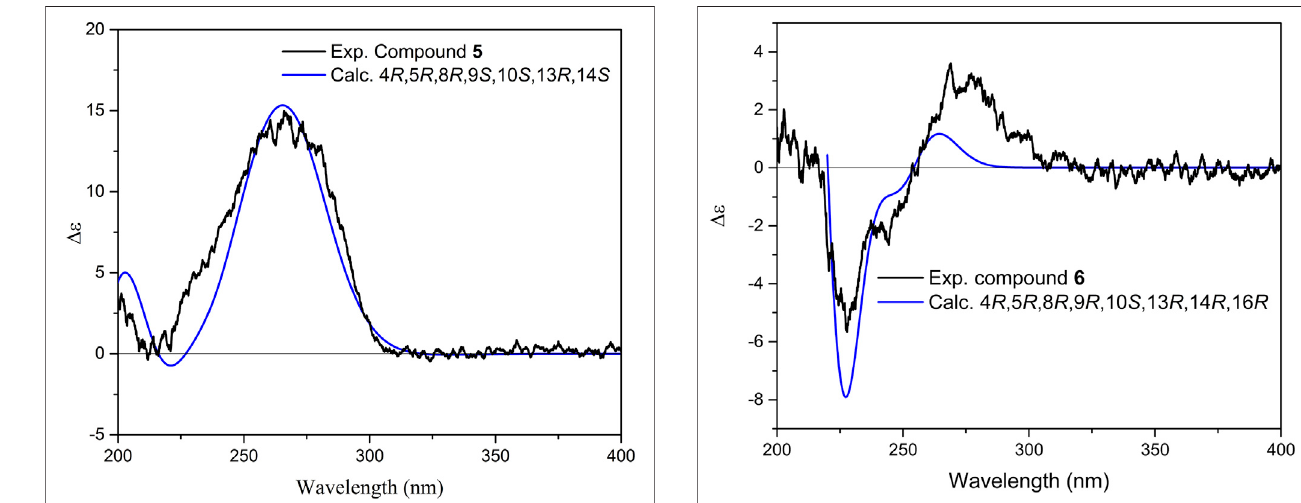
FIGURE 8 | Comparison of experimental and calculated ECD spectra of compound 5 at TD-DFT/B3LYP/6-31+G(d,p) basis set and level of theory in acetonitrile.